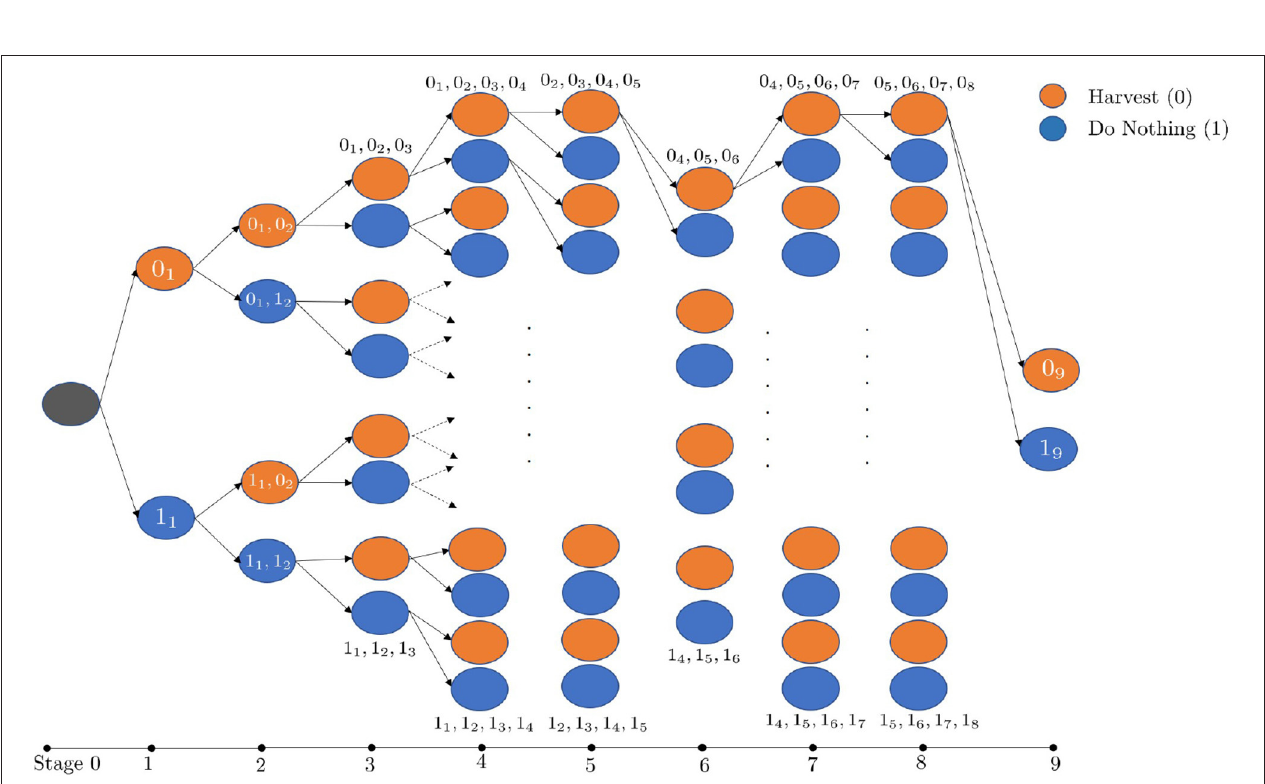
FIGURE 4 | The state space of the 3 3 stands case. The binary values indicate the actions taken and the lower subscript is the stand index. ×